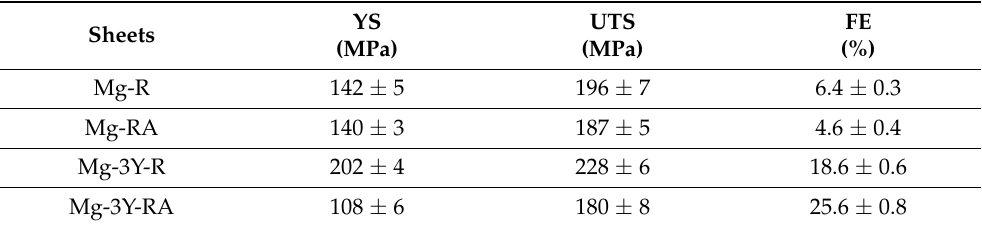
Table 4. Tensile properties of the sheets at room